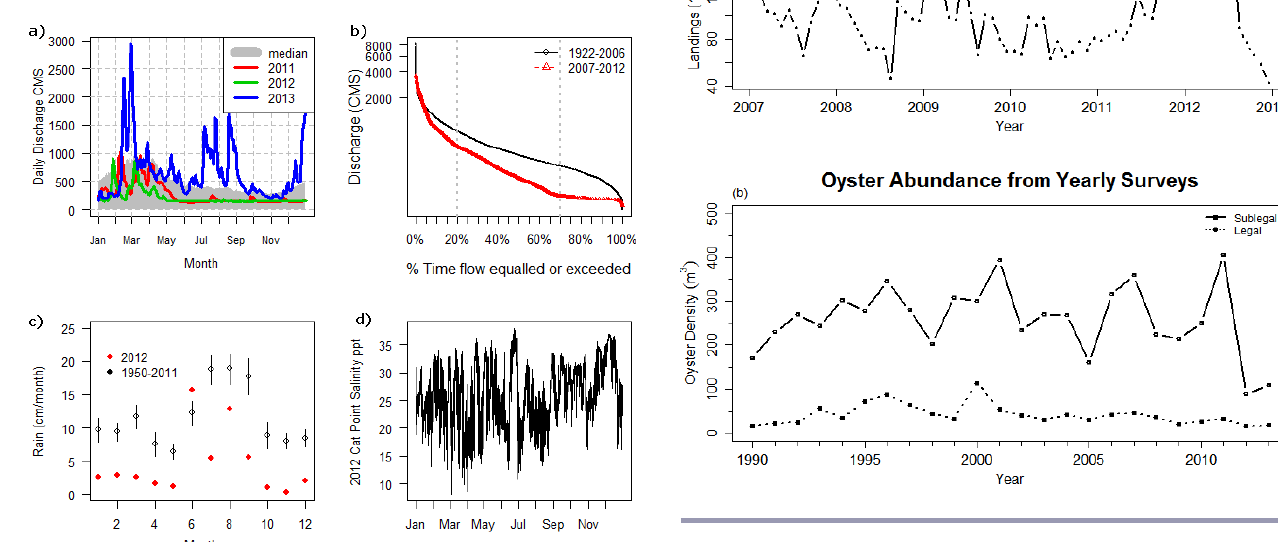
Fig. 3 . River discharge (cms, panel a) at USGS Gauge 02358000 in the Apalachicola River for 2011, 2012, and 2013 (colored lines) and the median river discharge (grey shaded area). River discharge (cms) duration curve (panel b) showing river discharge exceedance from 1922-2005 (black line) and from 2007-2012 (red line). Monthly rainfall (panel c) from 2012 from the Apalachicola, Florida airport (red dots), and monthly averages and bootstrap resampled 95% confidence intervals from 1950-2012 (black circles and lines). Salinity (ppt; panel d) during 2012 measured at Cat Point by continuous water quality monitoring meters located near the surface of Apalachicola Bay and maintained by Apalachicola National Estuarine Research Reserve Lab staff.